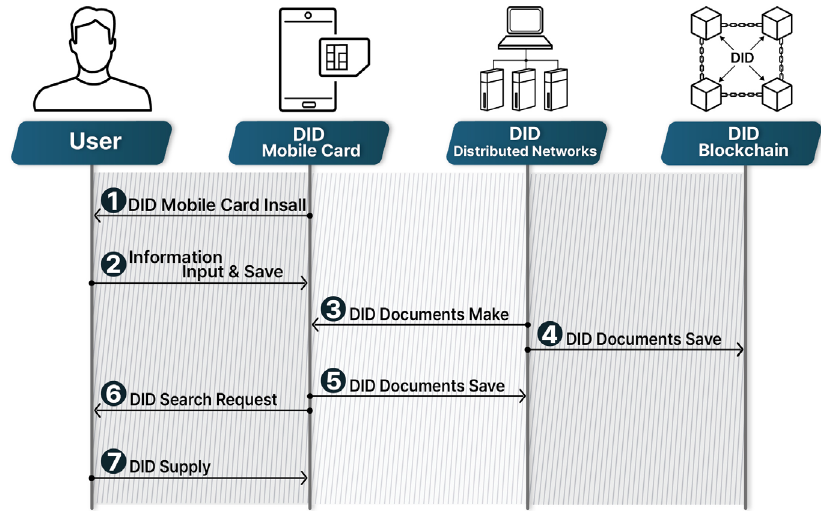
Figure 5. UML-based flowchart with entities.